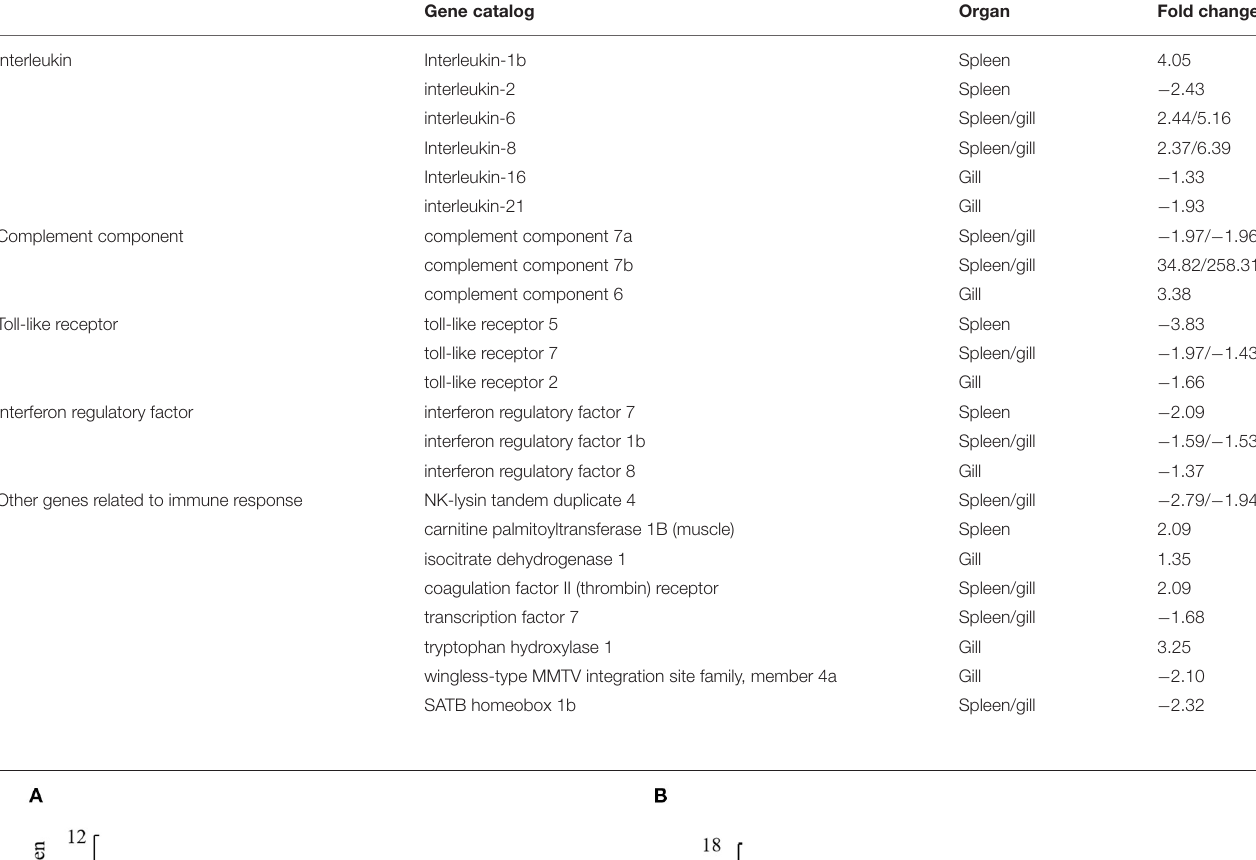
TABLE 1 | Partial differentially expressed immune-related genes in T. rubripes after V. harveyi infection.